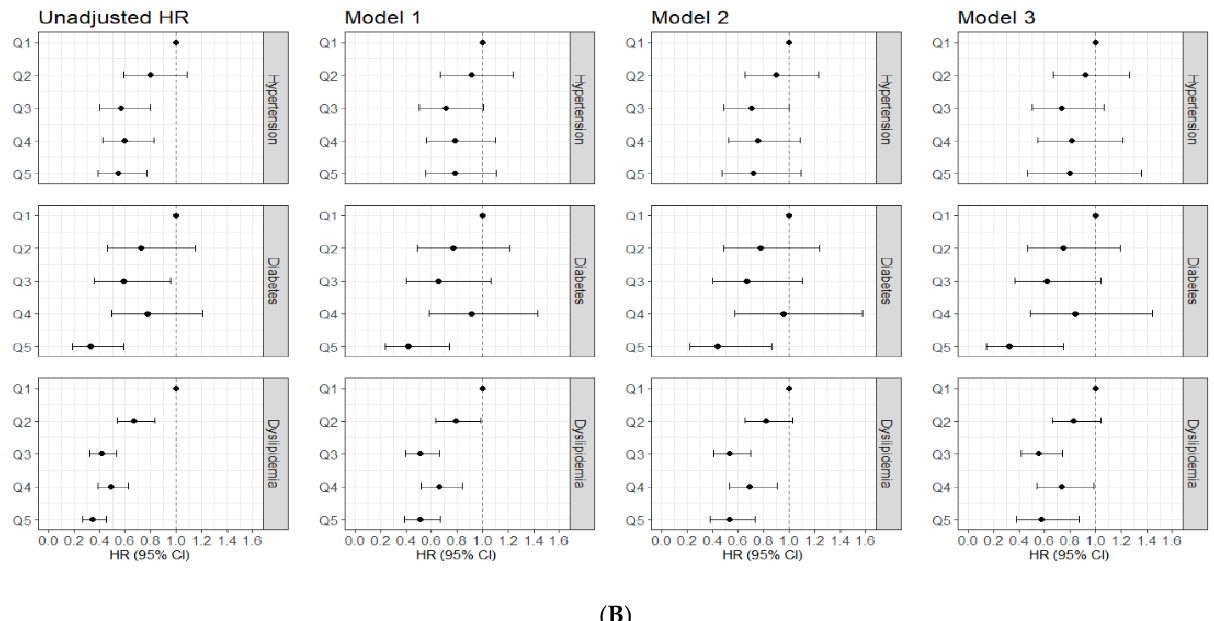
Figure 3. Association between dietary fiber intake and all-cause mortality and cardiovascular disease mortality according to hypertension, diabetes, and dyslipidemia. ( A ) All-cause mortality, ( B ) Cardiovascular disease mortality. HR: hazard ratio; CI: confidence interval